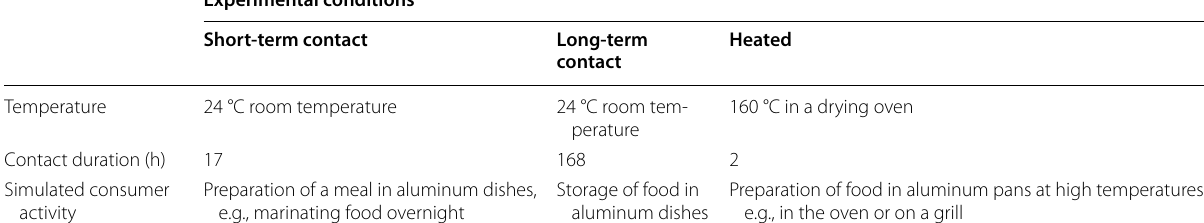
Table 1 Description of the three different conditions used in testing aluminum pans Experimental